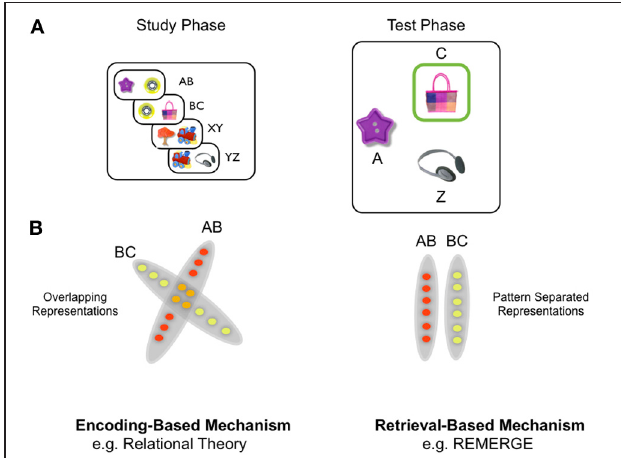
FIGURE 1 | Paired associative inference (PAI) task and schematic of difference between encoding-based and retrieval-based models of inference. (A) Overall design of PAI task: participants see overlapping object pairs during study (e.g., AB, BC) and are required to generalize during the test phase by exploiting indirect relationships between objects (e.g., A—C): see main text for details. (B) Schematic of difference at the representational level between encoding-based and retrieval-based models, exemplified by the relational theory and REMERGE model, respectively. Left panel: encoding-based models (e.g., relational theory: Cohen and Eichenbaum): A—C relationship represented through overlapping conjunctive representations in the hippocampus which are created during the study phase. In this highly simplified illustration, each circle denotes a single neuron (or population of neurons)—red circles denote neurons which code for study episode AB and yellow circles denote those coding for episode BC. Orange circles denote neurons that participate in the representation of both AB and BC episodes (cf. nodal codings—see main text). Neuronal representations of AB and BC are overlapping, as if within a “memory space” (see Eichenbaum et al., 1999). Right panel: Retrieval-based models (e.g., REMERGE: Kumaran and McClelland) emphasize a principle of pattern separation in the hippocampus—depicted in extreme form as zero overlap between related episodes (AB, BC). Indirect relationships are not actually represented, therefore, but computed at the point of retrieval—which in REMERGE occurs through a recurrent mechanism which supports the dynamic interaction of pattern separated codes for related